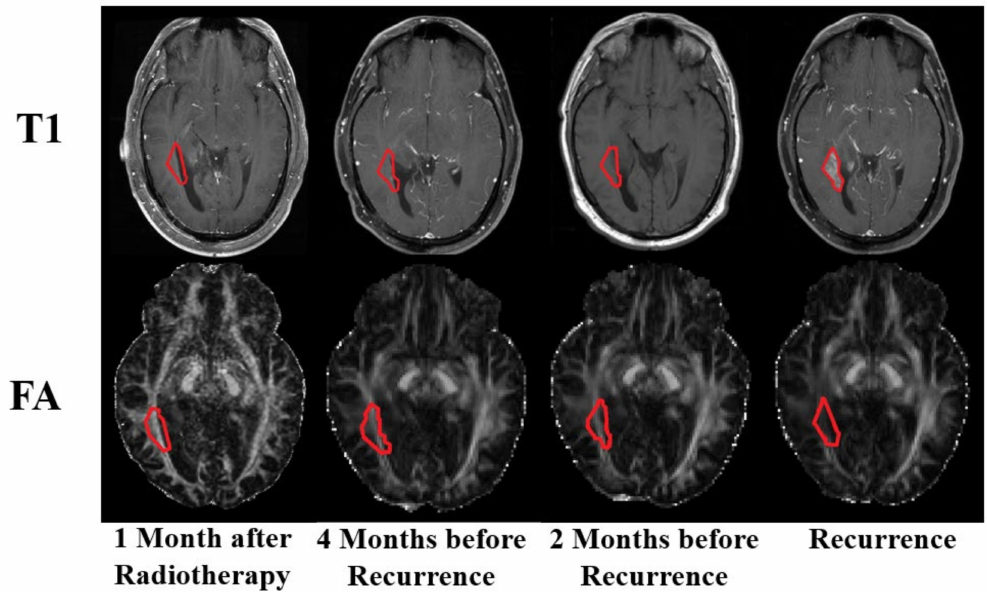
Figure 3. Serial T1 and fractional anisotropy (FA) images of a representative patient. Red outlines indicate the location of the recurrent